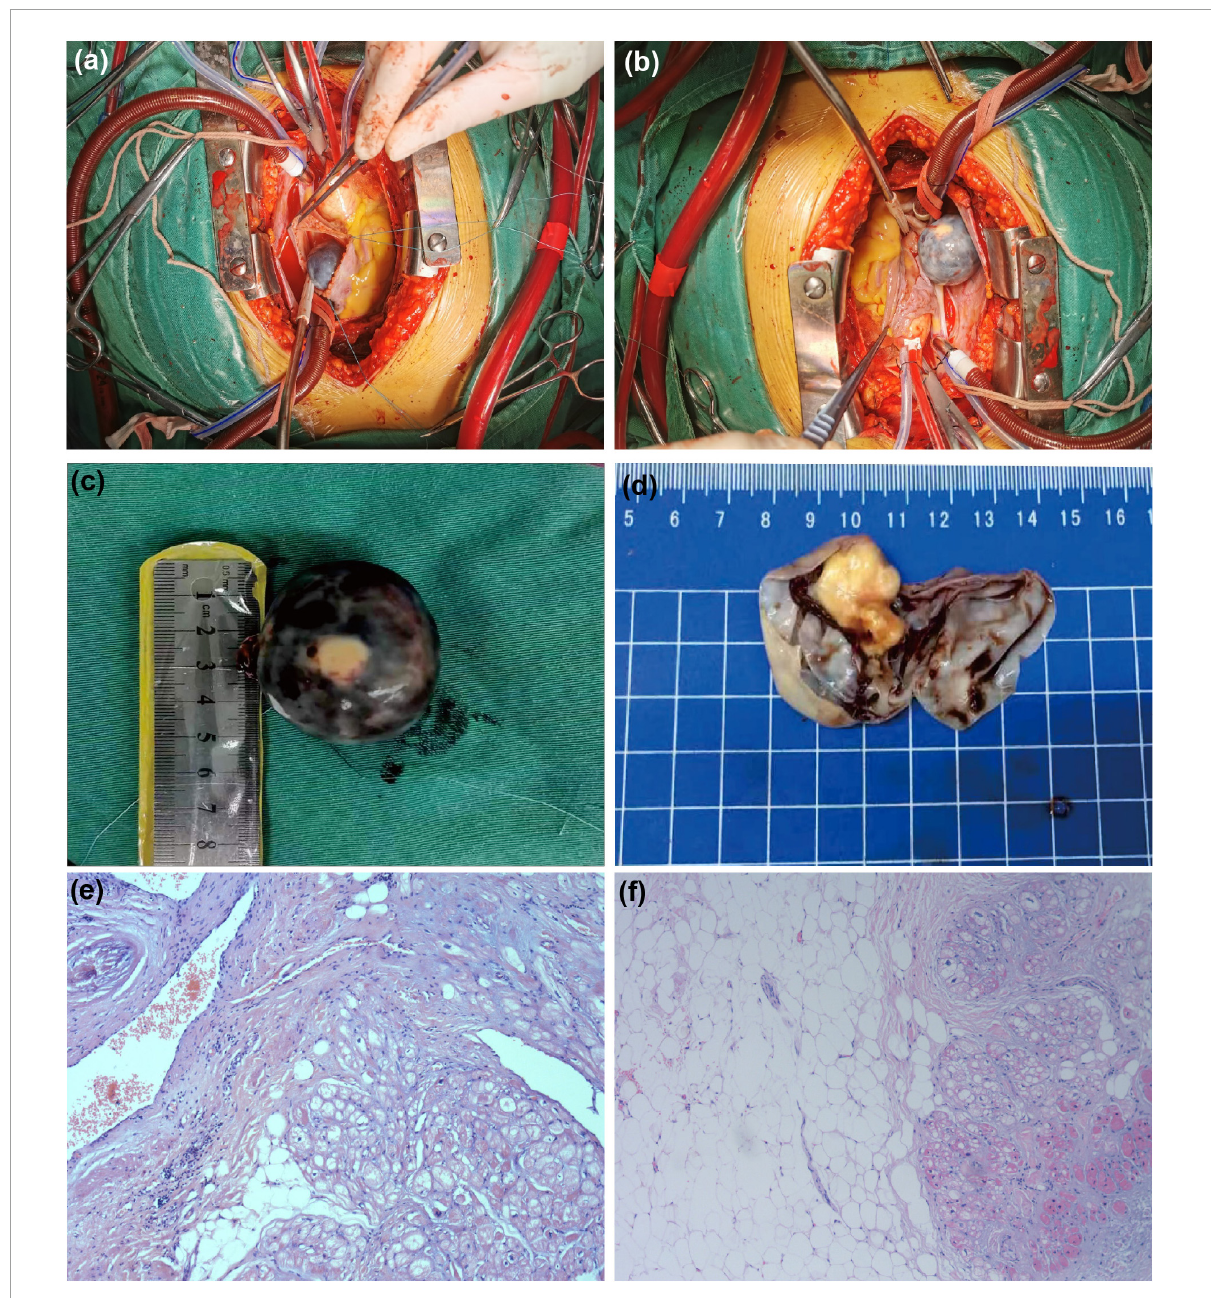
FIGURE4 Surgical and pathological results. The tumor was spherical mass (A) and that was connected to the right atrial side of the right atrial septum under the oval fossa with a small tumor pedicle (B) . (C) The ex vivo tumor was black spherical. (D) It can be observed that the yellowish white solid tumor with rough texture is attached to one side of the cyst wall after dissecting the tumor. (E,F) Stained with hematoxylin and eosin (H&E) at 10 magnification: the tumor comprised mature adipocytes with entrapped myocardial